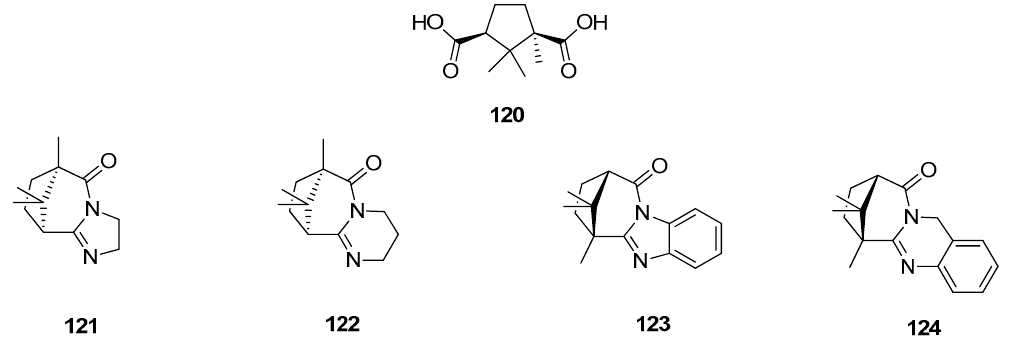
Figure 31. Polycyclic nitrogen-containing heterocyclic compounds ( 121–124 ) being (+)-camphoric acid ( 120 ) derivatives. ( 120 )